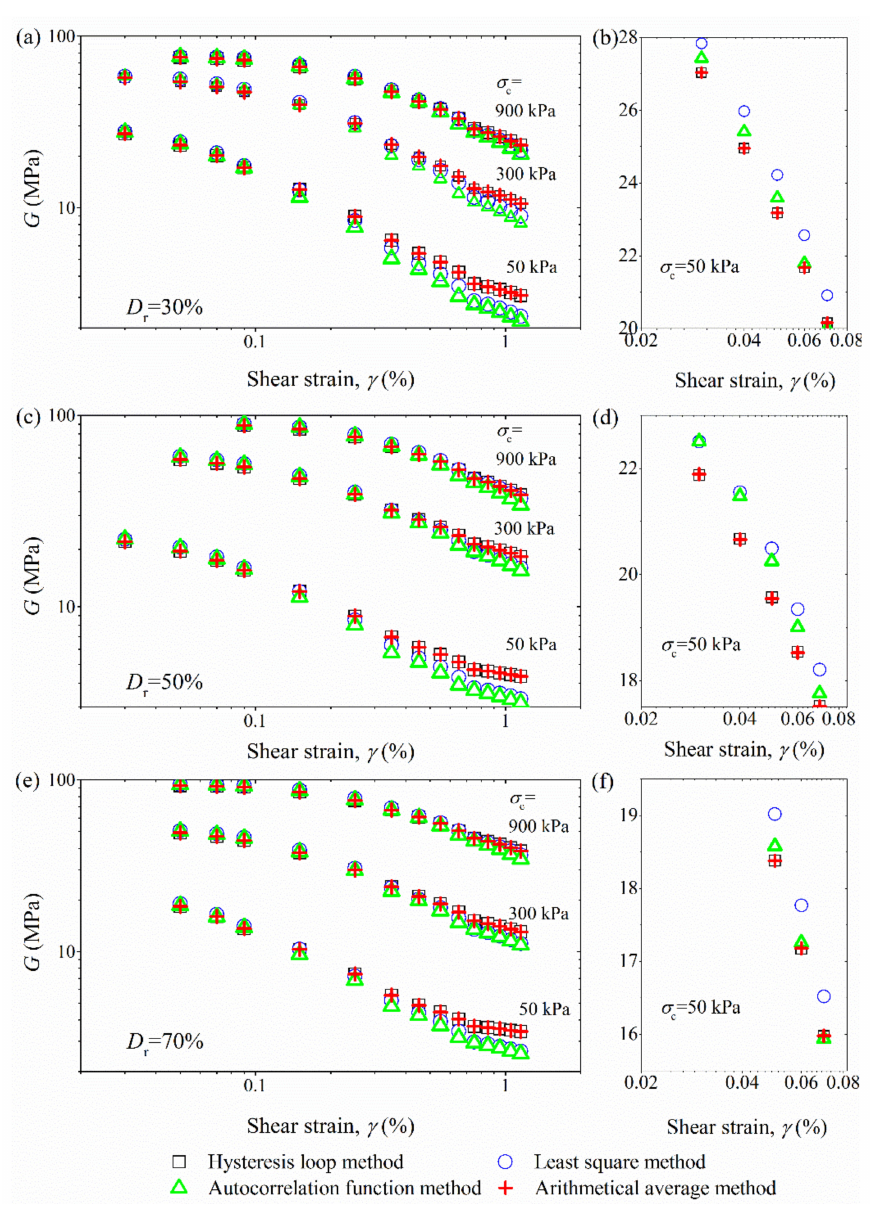
Figure 7. Representative G- γ curves for four determination methods ( a ) D r = 30%, ( c ) D r = 50%, ( e ) D r = 70%, and ( b , d , f ) are the corresponding subplots for σ c = 50 kPa. At higher shear strain (10 − 3 –10 − 2 ), an opposite trend is observed. Both the autocorre- lation function method and least square method predict the smaller G in comparison to the hysteresis loop method, with the minimum value appearing for the